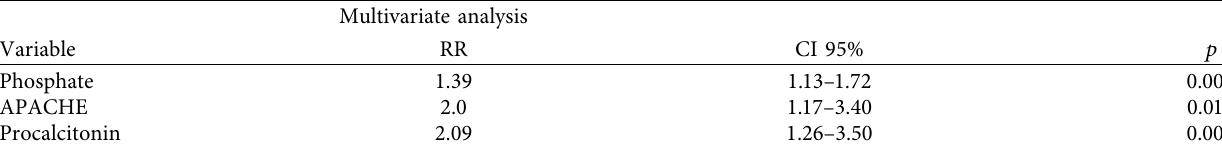
Table 3: Multivariate analysis for risk factors associated with acute kidney injury (AKI) in patients with COVID-19. Multivariate